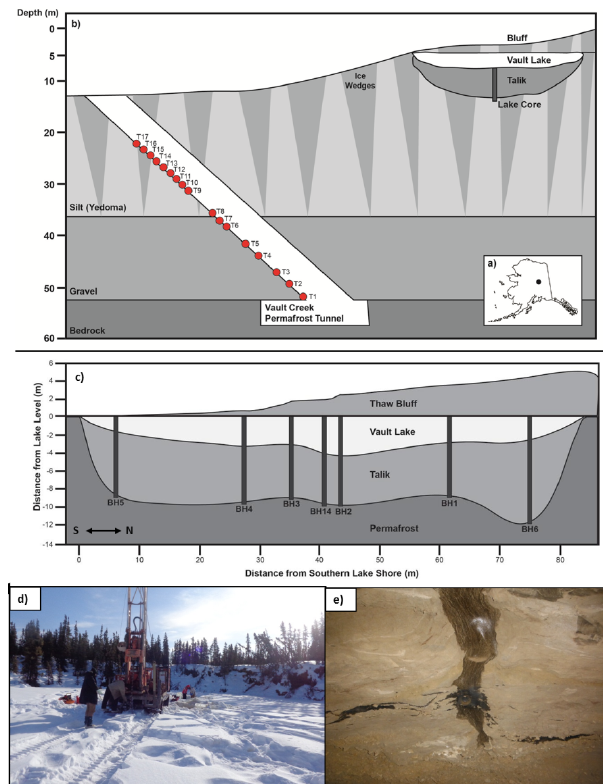
Figure 1. Location map (a) , study site overview (b) , and Vault Lake morphology shown in cross section along the long axis of the lake (c) for Vault Lake and Vault Creek permafrost tunnel, Alaska, USA (65.0293 ◦ N, 147.6987 ◦ W). Height of the thaw bluffs was measured using differential GPS (DGPS). Depth of the Vault Lake talik was measured using the delineated borehole transect (c) . Thaw bluff heights, lake depth, talik depths, and distance between bore- holes (b, c) are shown to scale. Vault Lake is a 3230m 2 , 3.7m deep thermokarst lake with thermokarst bluffs (d) ranging from 0.2 to 4.5m in height and a 5.9m deep talik underneath. The Vault Lake core was collected from the center of the lake (BH14). The Vault Creek permafrost tunnel extends 220 to 40m depth below the ground surface. Ice wedges (e) are present to 23m depth. Tunnel sampling sites are marked as red dots; numbers adjacent to the dots represent incubation sample IDs. Photographs by K. M. Walter An- thony (d) and J. K. Heslop (e)